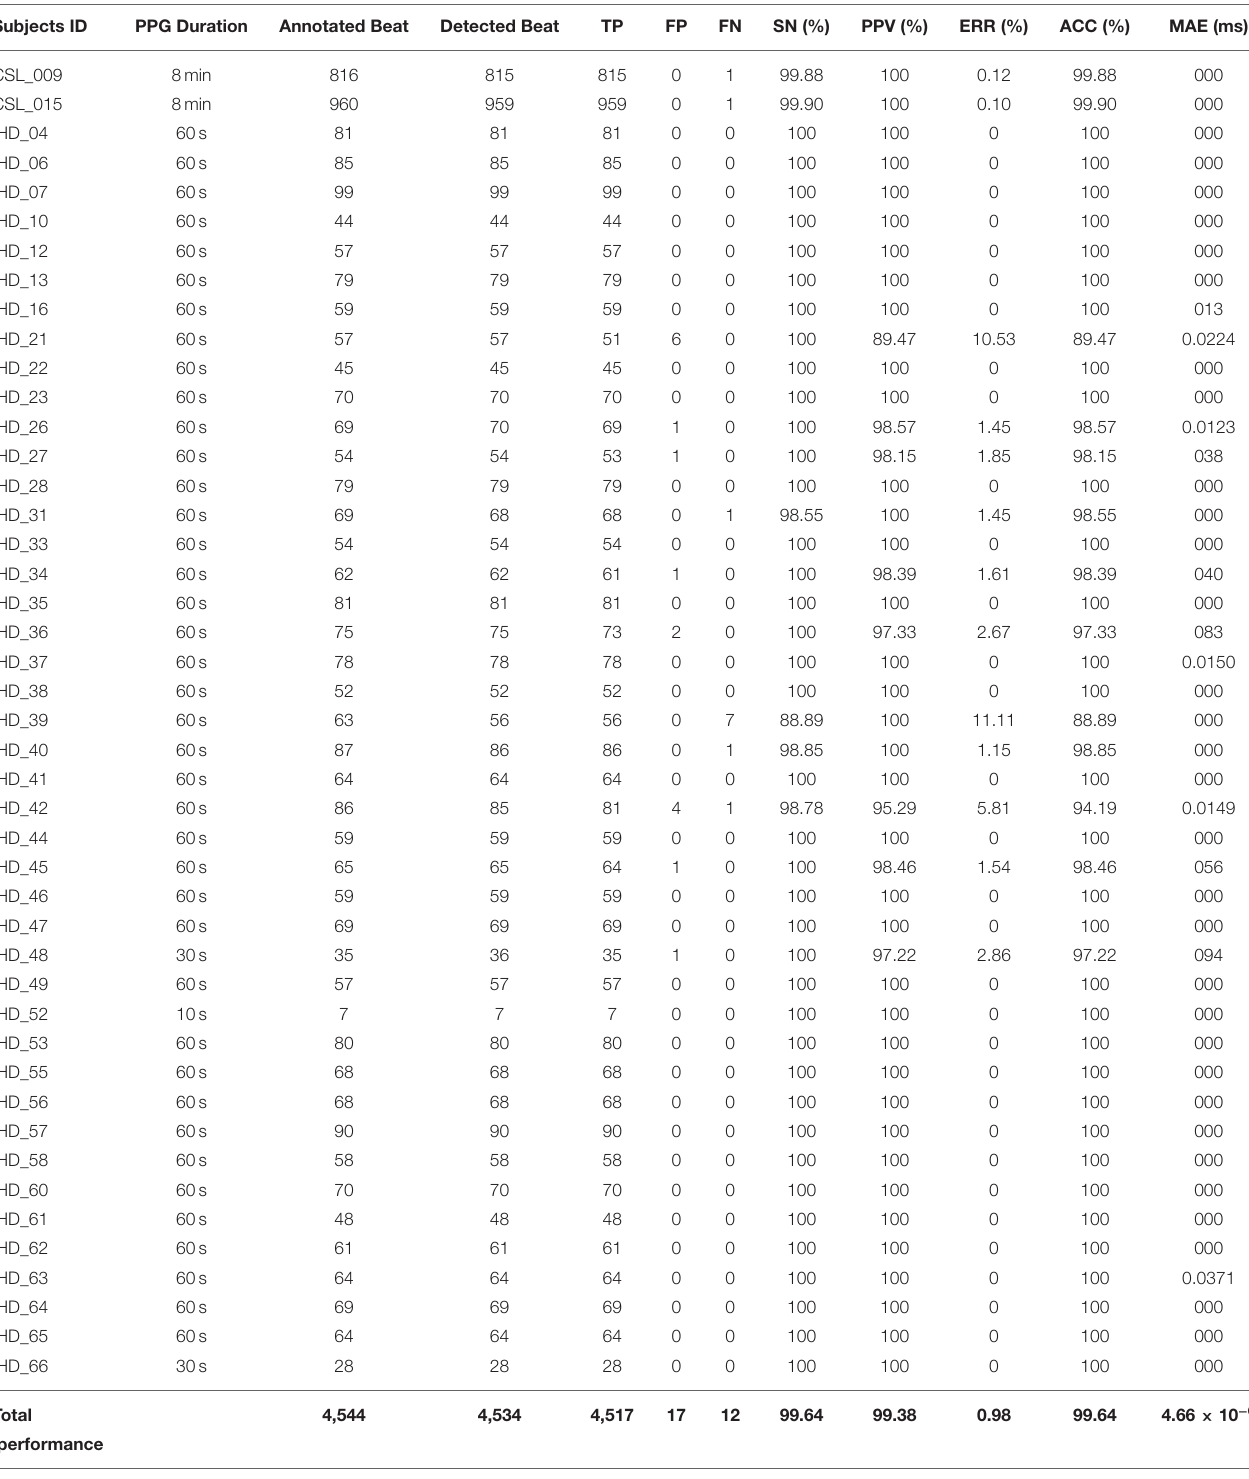
TABLE 3 | Performance of systolic peak detection from two CSL subjects and 43 IHD subjects. Subjects